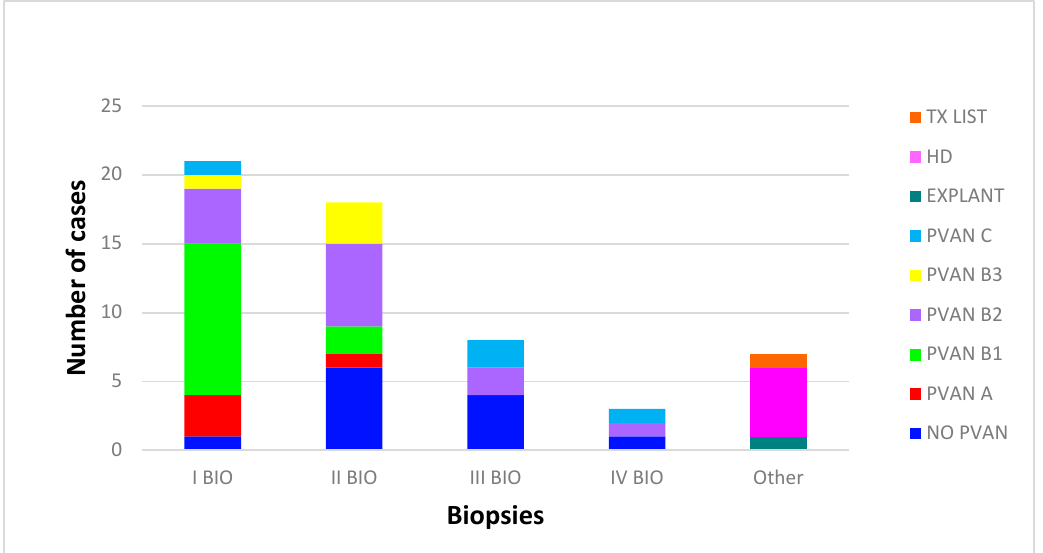
Figure 2. Histological results and polyomavirus nephropathy (PVAN) staging at renal biopsies. Tx list, entry in transplant list; HD, hemodialysis.